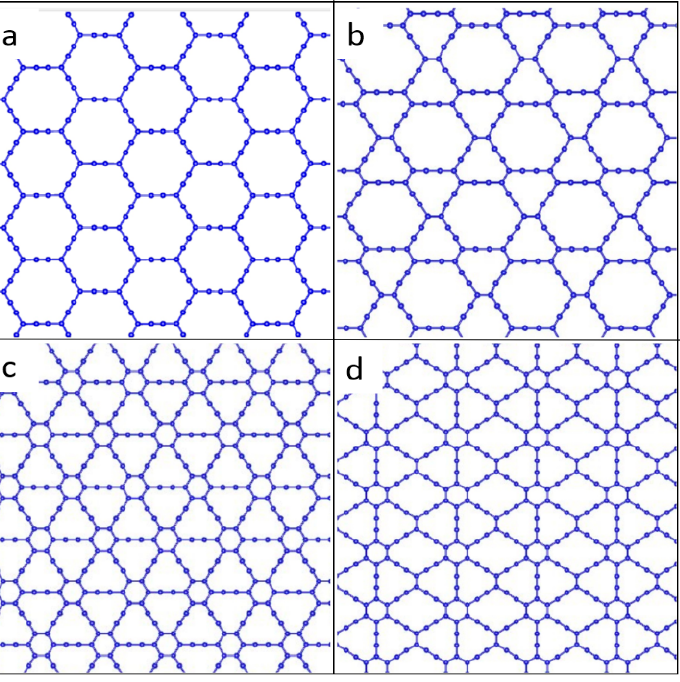
Figure 1. Atomic structure of four types of graphyne: ( a ) α -graphyne, ( b ) β -graphyne, ( c ) γ -graphyne, and ( d ) 6,6,12-graphyne.